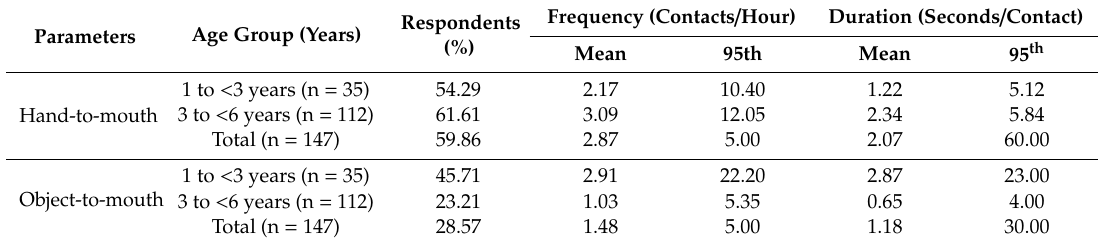
Table 8. Mouthing activity of Korean children aged 1–6 years.